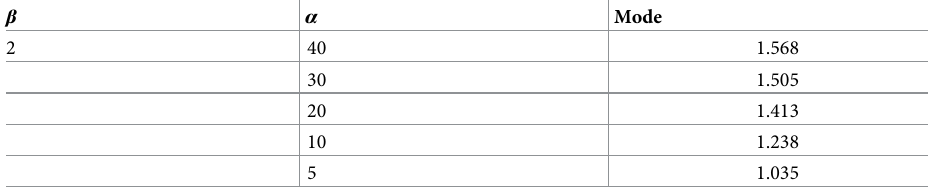
Table 1. Mode for different choices of α and β